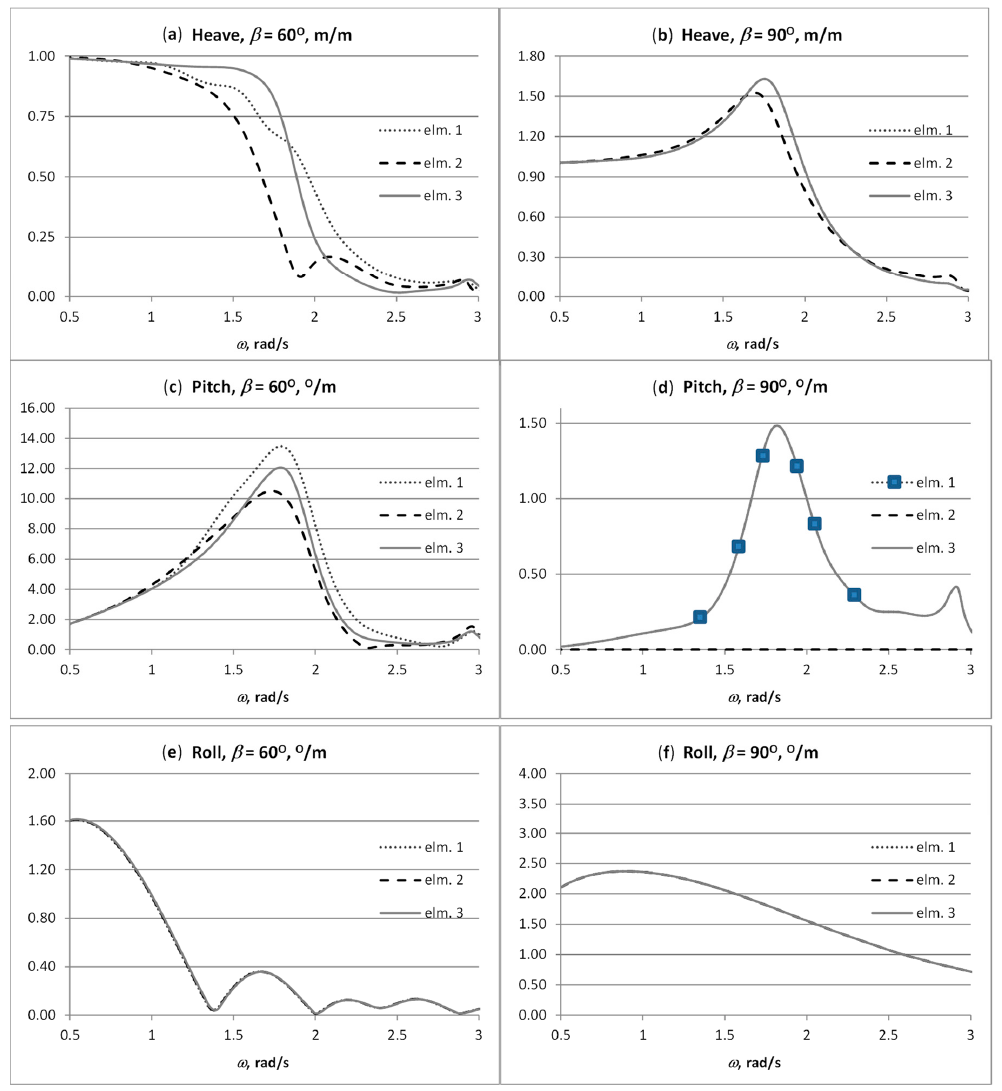
Figure 4. The response amplitude operators (RAOs) for each of the three breakwaters: a) Heave for incoming wave direction 60 ° ; b) Heave for incoming wave direction 90 ° ; c) Pitch for incoming wave direction 60 ° ; d) Pitch for incoming wave direction 90 ° ; e) Roll for incoming wave direction 60 ° ; f) Roll for incoming wave direction 90 ° . J. Mar. Sci. Eng. 2019 , 7 , x FOR PEER REVIEW 10 of 14